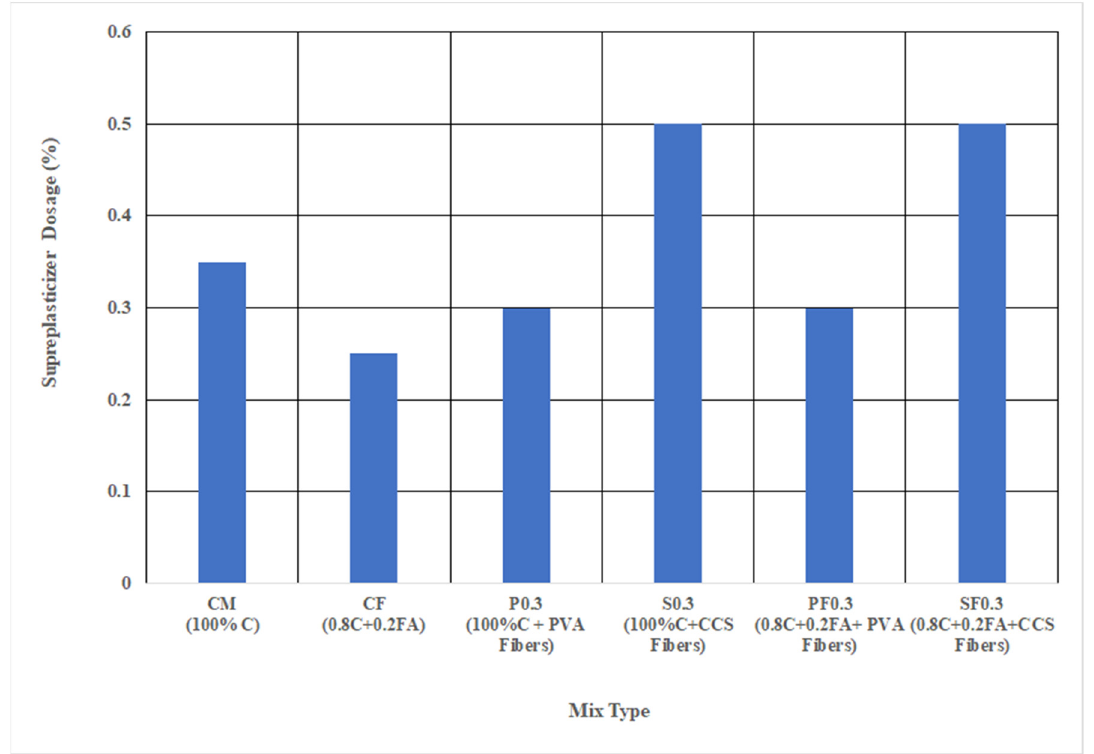
Figure 4. Superplasticizer dosage for achieving 90–110 mm slump in different concrete mixes. (Note: C is cement, FA is fly ash).